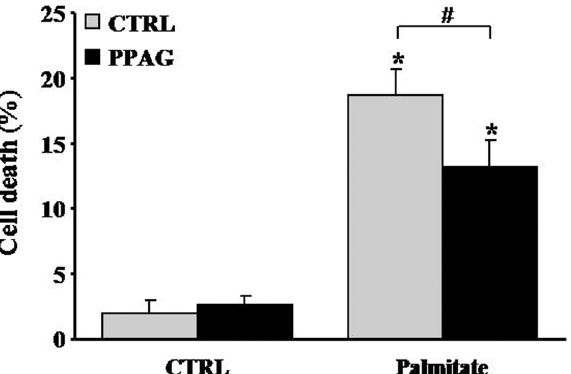
Fig 6. Effect of PPAG on lipotoxic cell death in human islet cells. Human islets were treated with 0.5 mM palmitate and 30 μ M PPAG or vehicle for 3 days (n = 4). The percentage of apoptotic (A) and necrotic cells (B) was determined following staining with the nuclear dyes propidium iodide and Hoechst 33342. A minimum of 500 cells was counted for each condition. * p < 0.05 against untreated cells, #p < 0.05 as